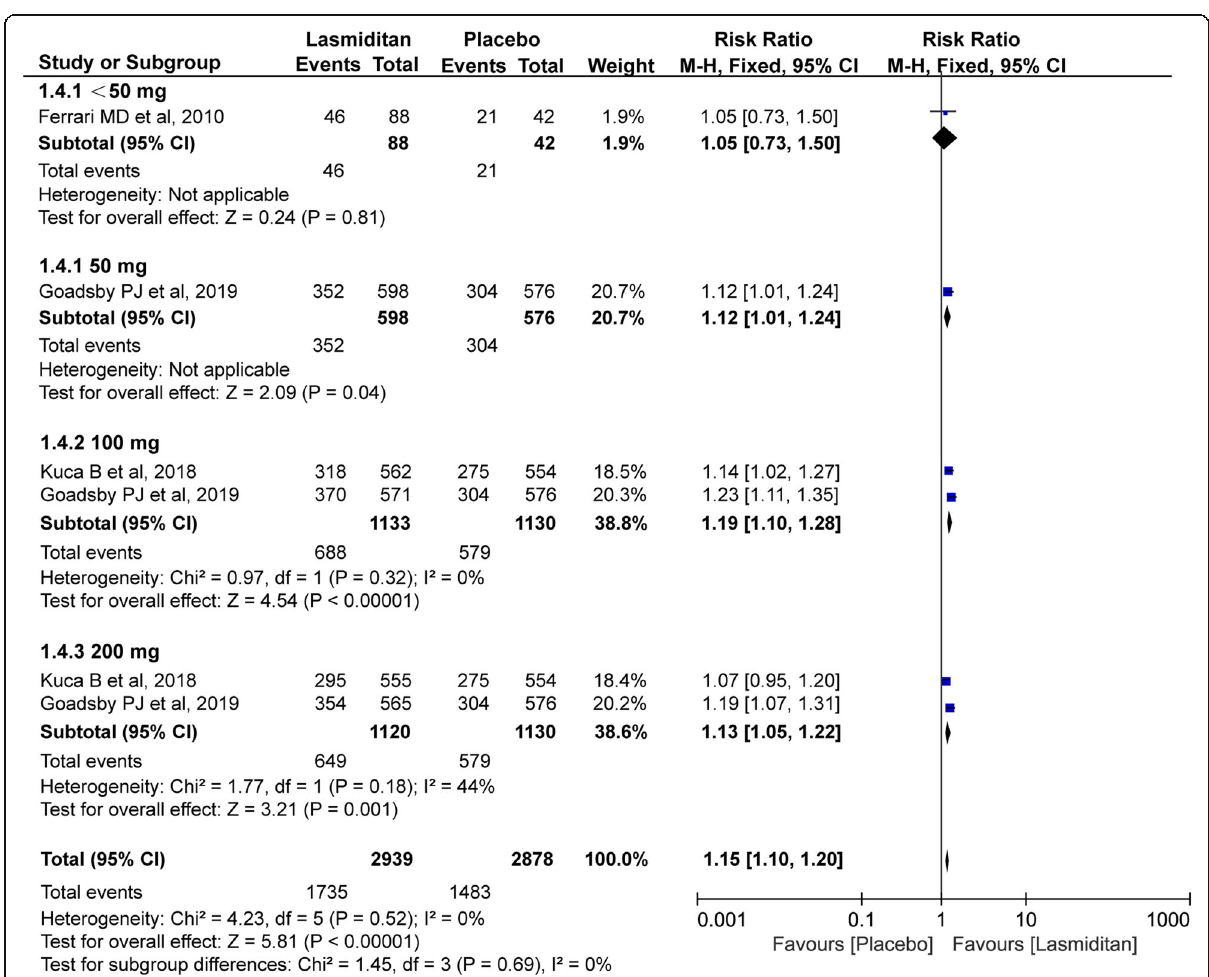
Fig. 6 Meta-analysis of the disability (no/mild) at 2 h after therapy with lasmiditan compared with placebo. The diamond indicates the estimated relative risk with 95% confidence interval for the pooled patients. M-H, Mantel-Haenszel; CI, confidence